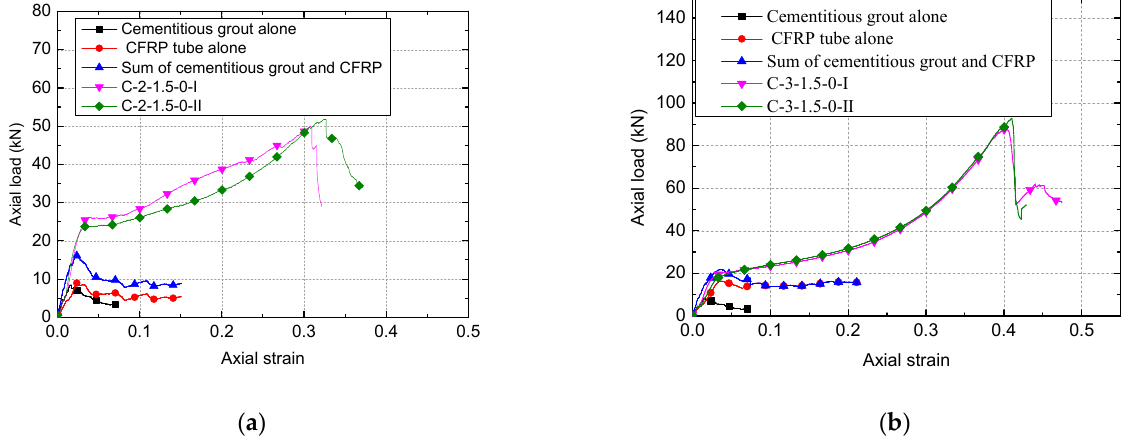
Figure 10. Typical load–strain curve of representative CSBM specimens: ( a ) the 2-layer case; ( b ) the 3-layer case.